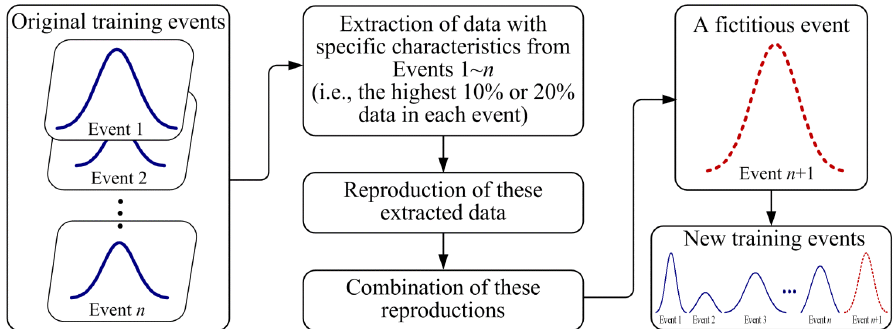
Figure 2. Graphical illustration of the enforced learning strategy.